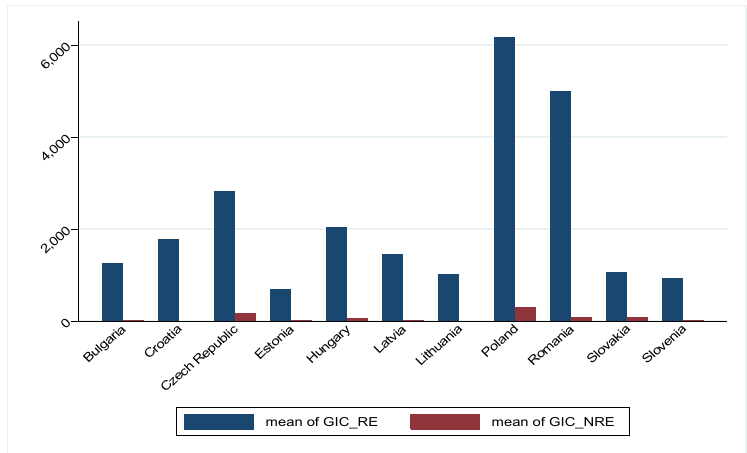
Figure 3. Mean values of gross inland consumption of renewable energies vs. waste, non-renewable. Source: Authors’ work. For the definition of variables, please see Table 2. Table 4 reveals the correlations between the Table 4. Correlation matrix.